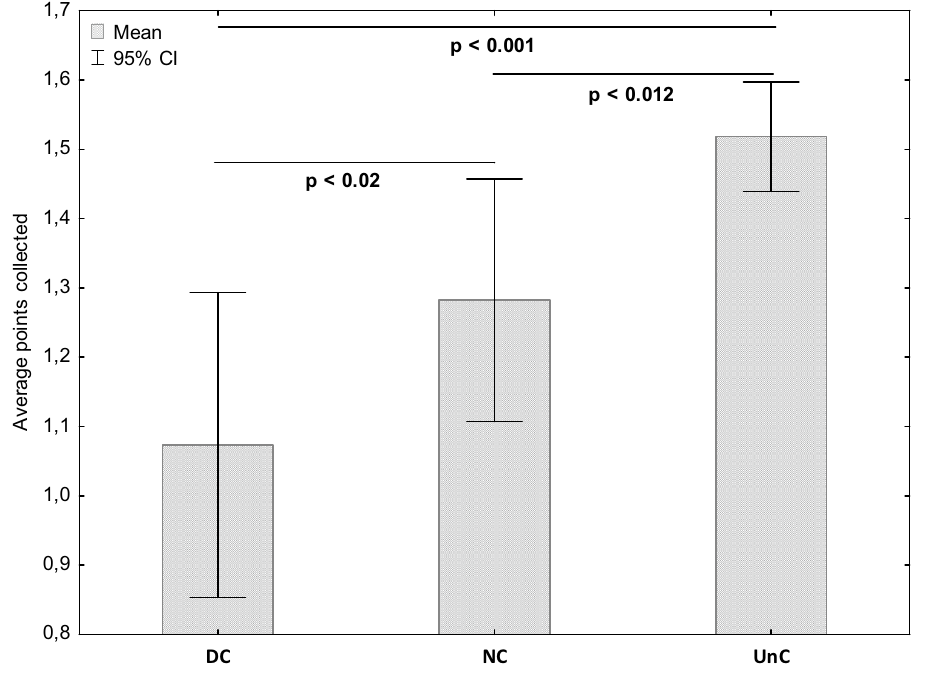
Figure 2. Comparison of average points collected by dismissed coaches (DC), new coaches (NC), and unchanged coaches (UnC).